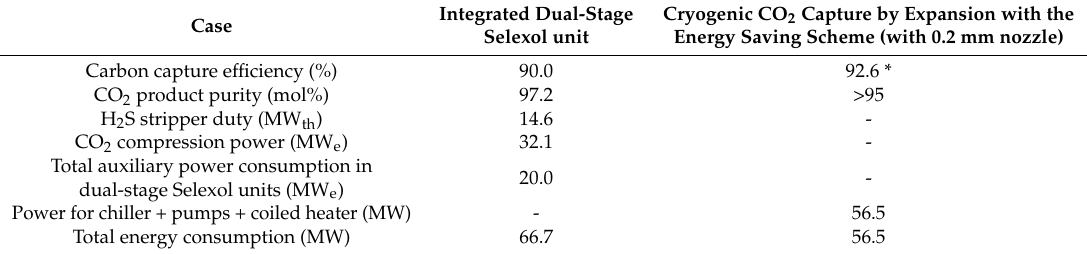
Table 5. Comparison of the energy consumption of the simulated dual-stage Selexol process and the simulated cryogenic energy-saving